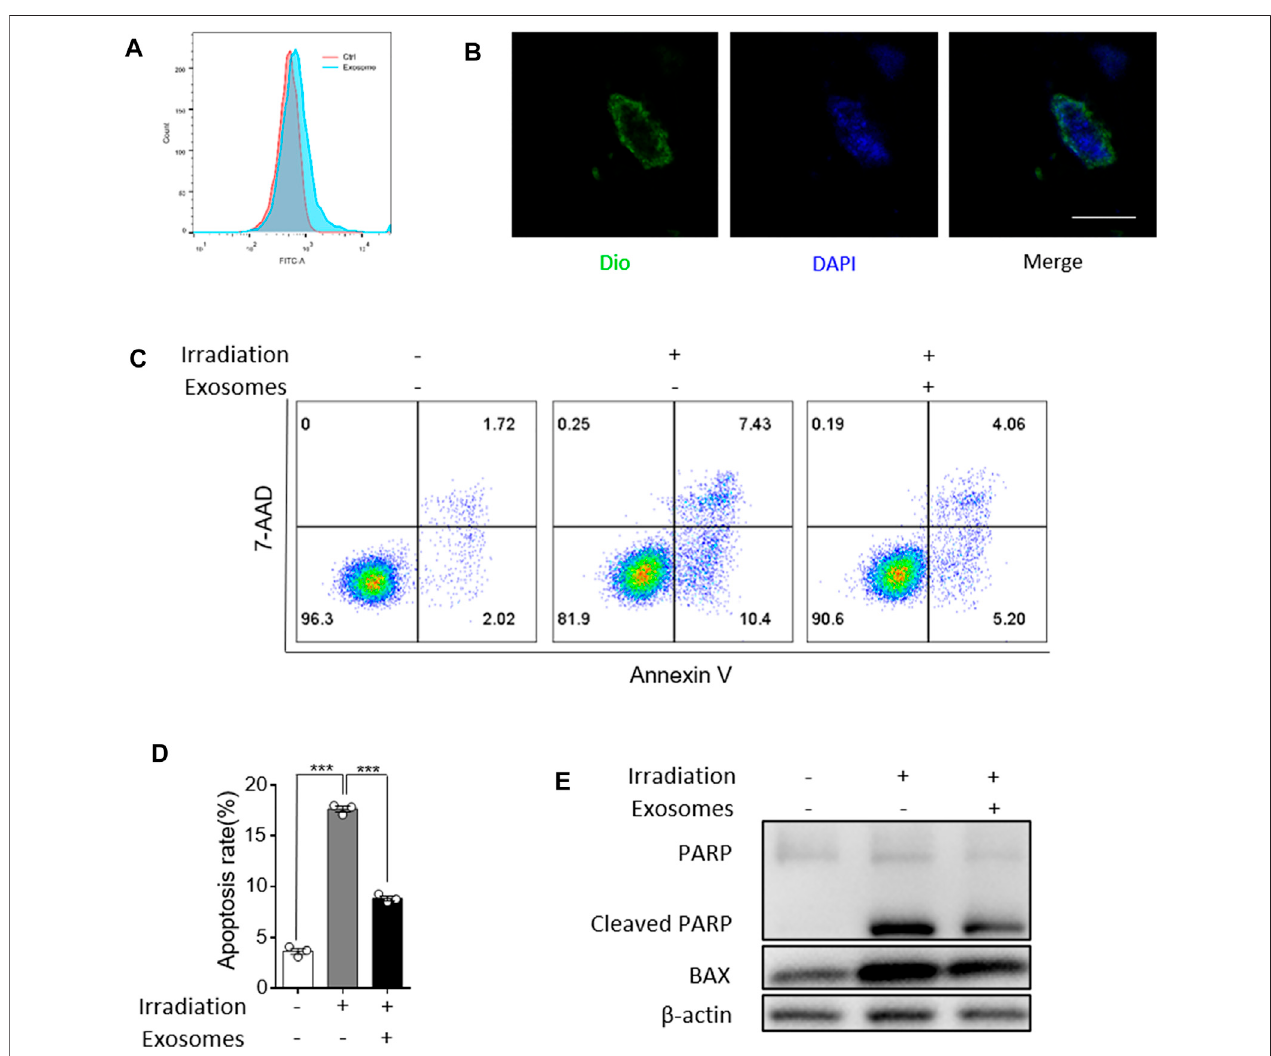
FIGURE 3 | Osteoblast derived exosomes inhibit irradiation induced apoptosis of FDC-P1. (A,B) Representative imaging showed the fl uorescence intensity signal detected by fl ow cytometry. Colocalization of OB-exosomes with FDC-P1 cells using confocal microscopy imaging. Exosomes were labeled by 3 ′ - dioctadecyloxacarbocyanine perchlorate (Dio, green) and cell nuclei were stained with DAPI (blue). Scale bar, 10 μ m. (C) FDC-P1 cells were irradiated with 2 Gy before treated with OB-exosomes, and apoptosis was measured by fl ow cytometry. n = 3/group (D) Statistical analysis of the difference between control, irradiation and co-cultured with OB-exosomes after irradiation groups (*** p < 0.001, mean ± sem, n = 3/group). (E) Detection of protein levels of Cleaved PARP and BAX in irradiated FDC-P1 by western blot.